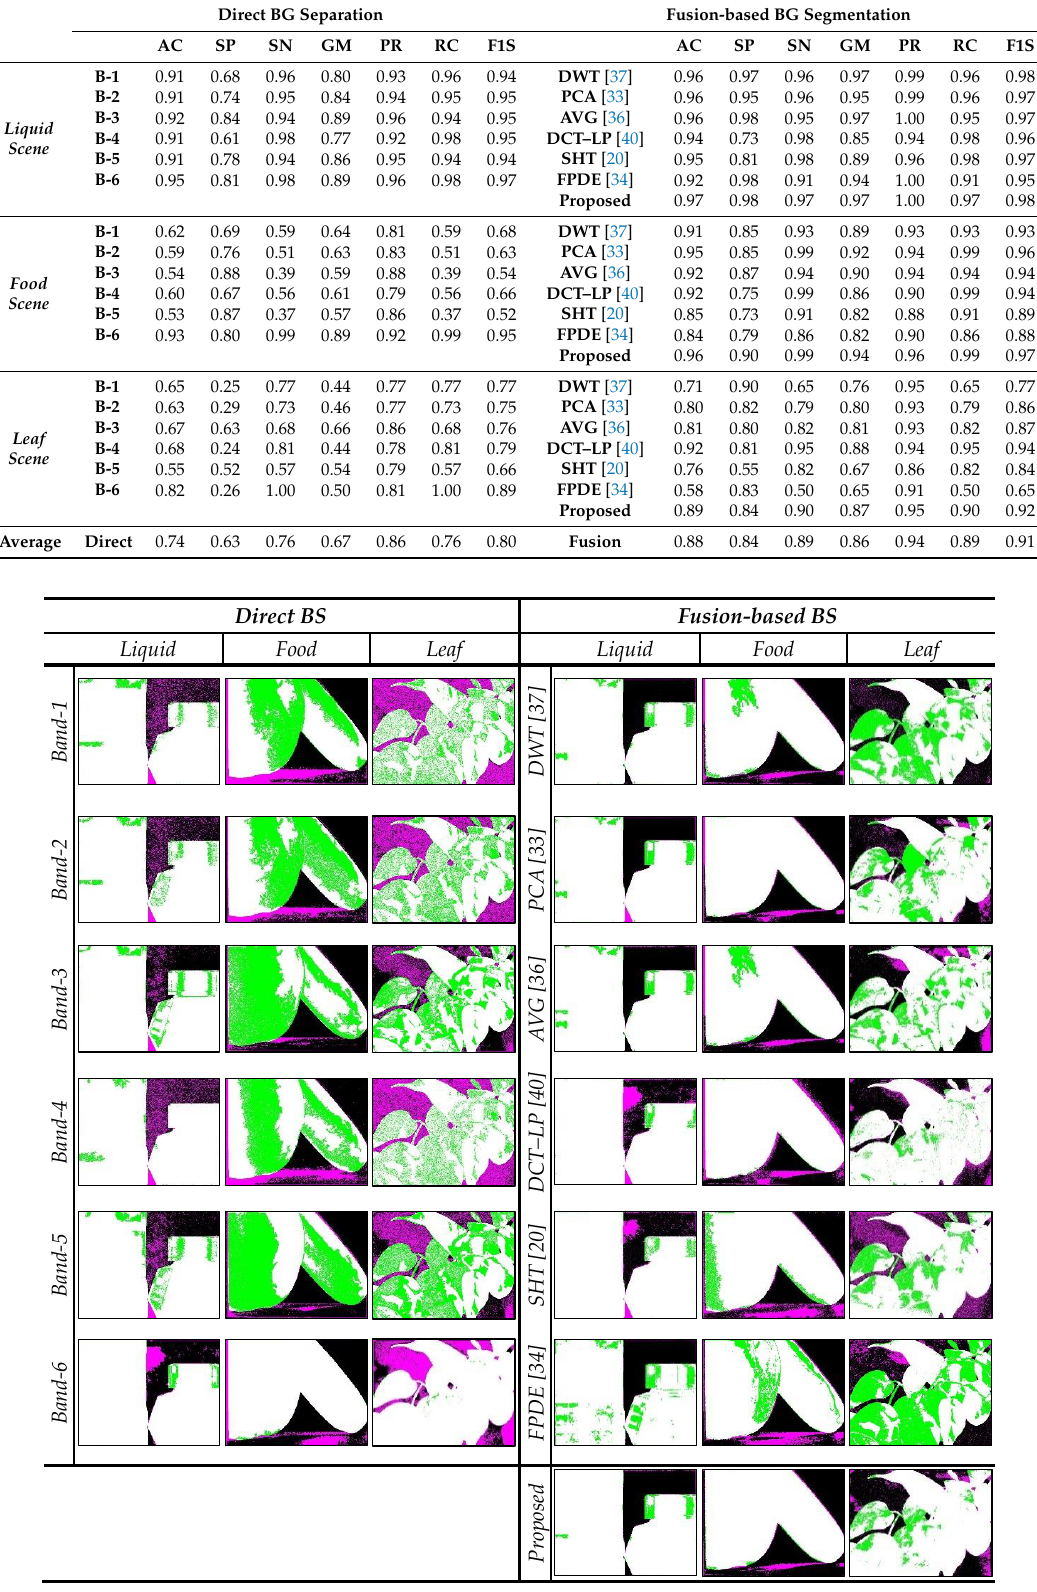
Figure 11. Direct vs. fusion-based segmentation errors of three scenes in the MSPI dataset.